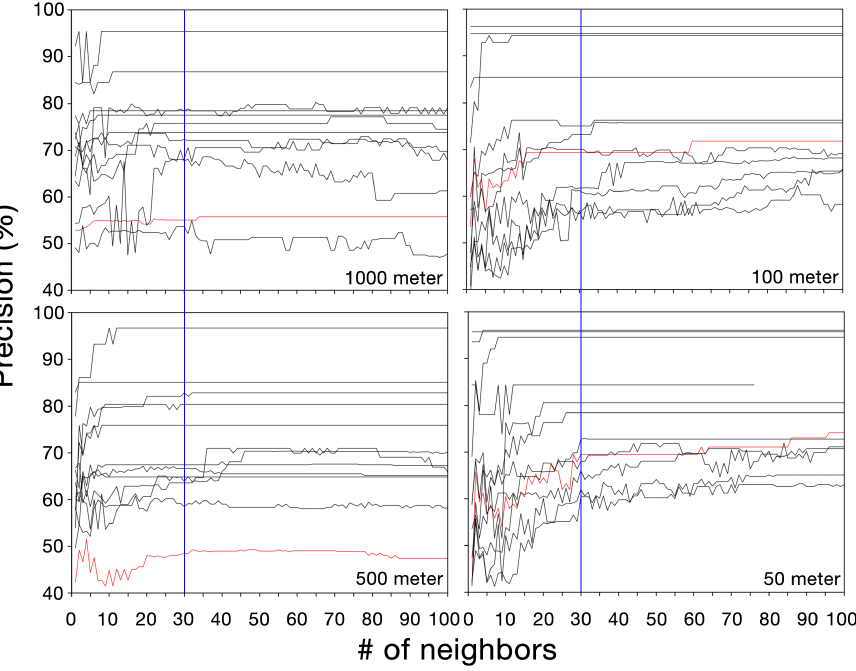
Figure 9. Selecting the best-performing number of neighbours of the k-nearest neighbours classifier for different tile sizes. The red curve represents the combined cities. The different black colours represent the individual cities. The vertical blue line characterises the selected value of 30 nearest